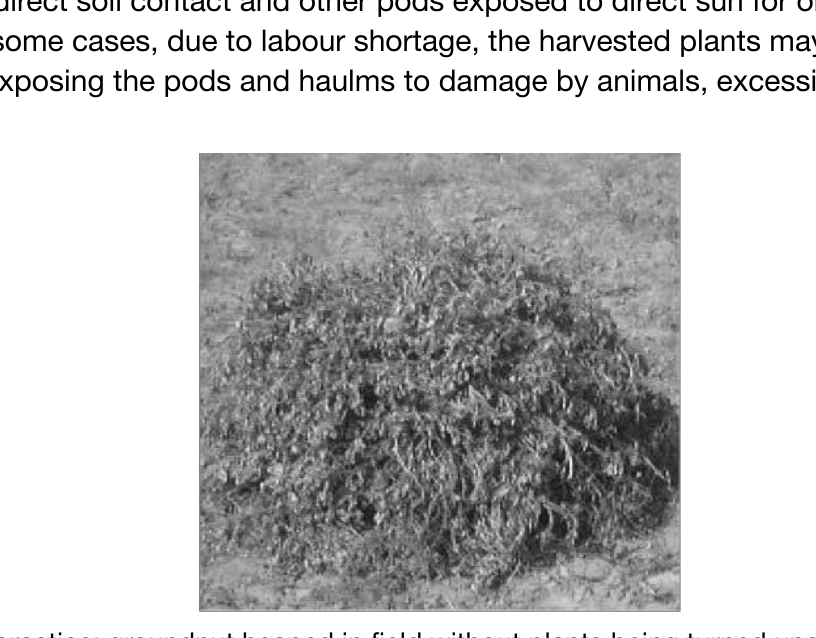
Photo 1: Bad practice: groundnut heaped in field without plants being turned upside down (Source: Waliyar et al., 2015 2